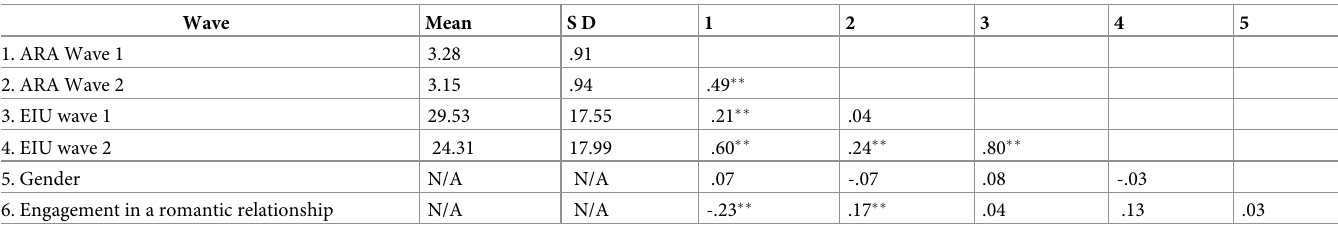
Table 3. Means, standard deviations,